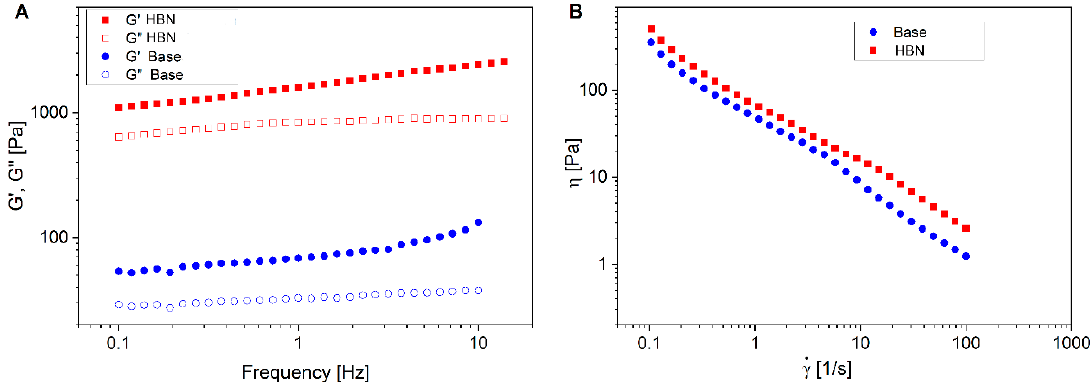
Table 1. Rheological properties of the control and the experimental formulation.